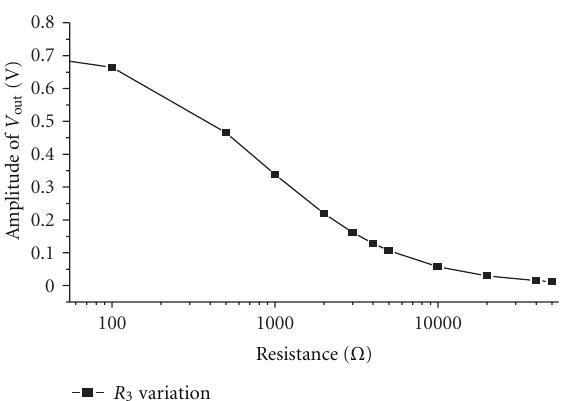
Figure 17: Response characteristic of the output voltage for the pulse parameter for a change of the resistance of R 3 (5 ( Ω ) ∼ 50 (k Ω )).